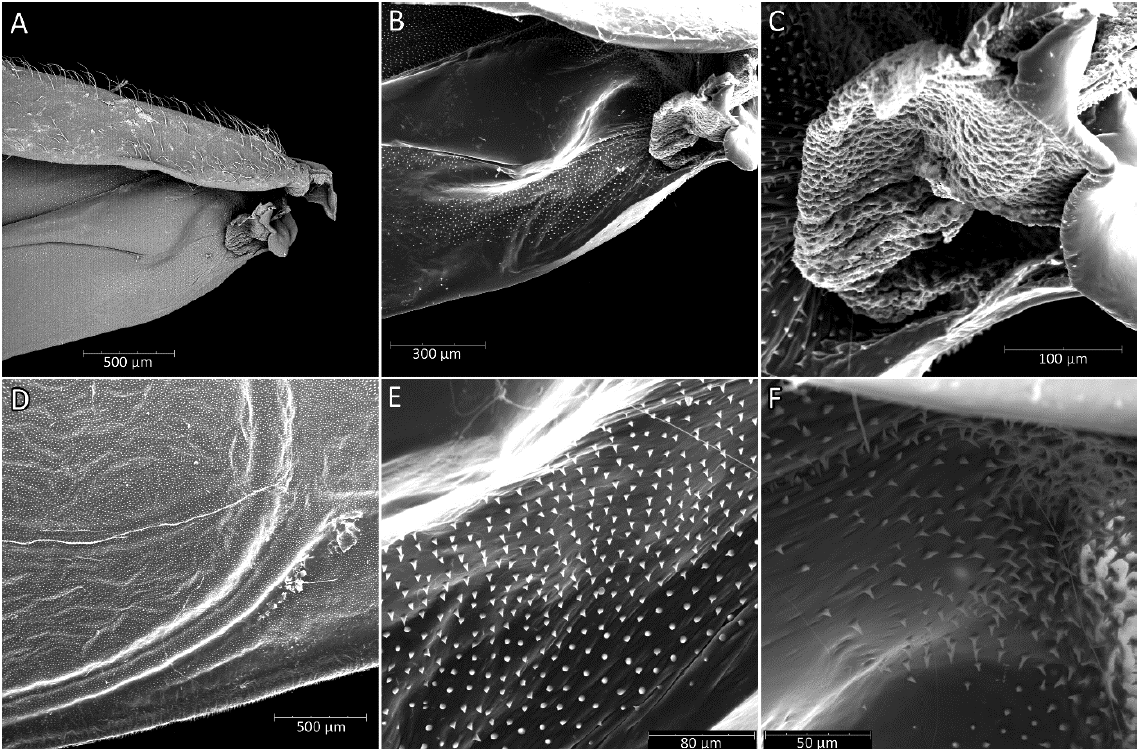
Figure 18. Ventral surface of the fore wing of Phonoctonus fasciatus (Beauvois, 1805). bc — basal cell; Cu — cubitus; dc — distal cell; M — media; PCu — poscubitus; PCu+A1 — poscubitus and first anal vein; quc — quadrate cell; R — radius; Sc — subcostal.